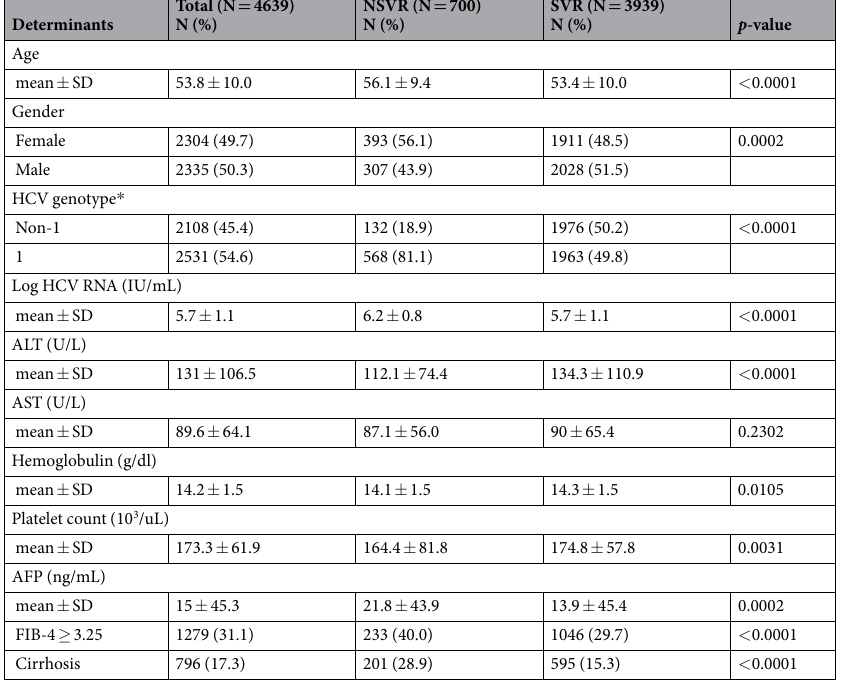
Table 1. Baseline characteristics of study participants. HCV: hepatitis C virus; ALT: alanine aminotransferase; AST: aspartate aminotransferase; FIB-4: fibrosis-4 score; AFP: α -fetoprotein; SVR: sustained virological response; NSVR: non-sustained virological